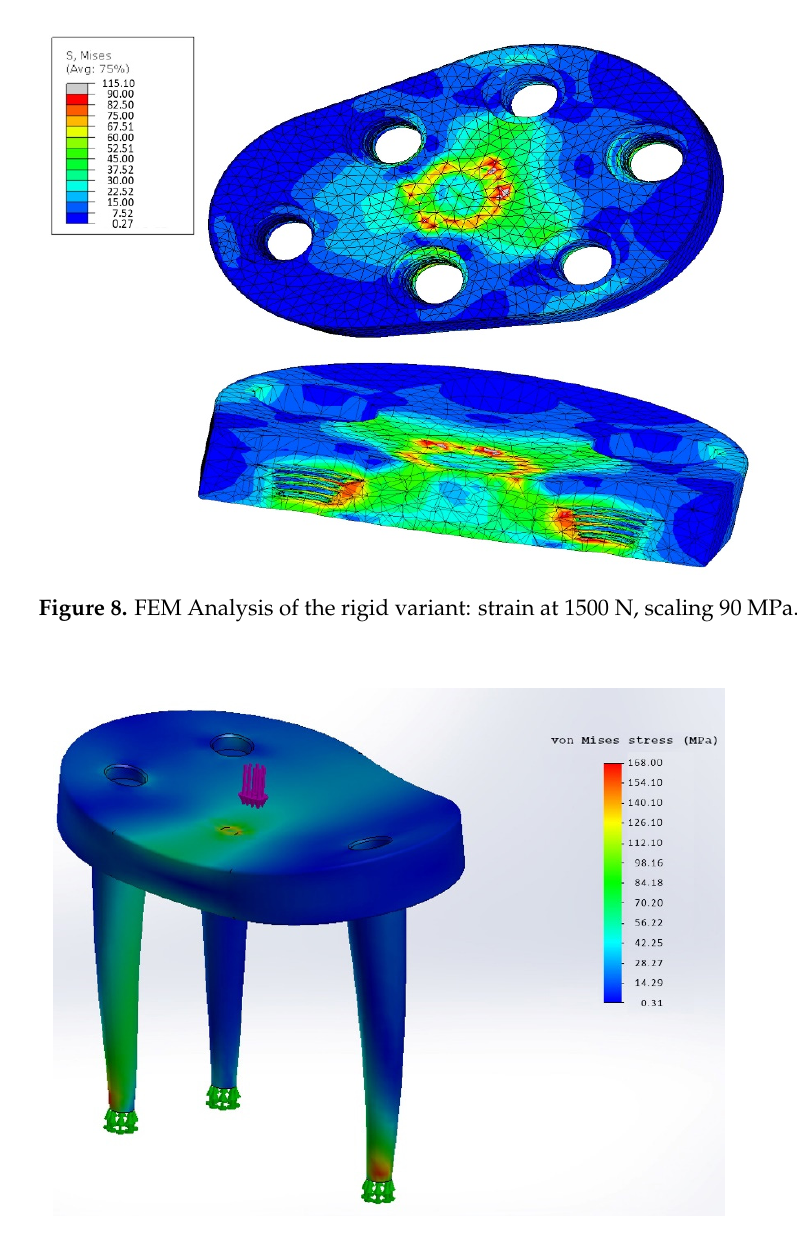
Figure 9. FEM Analysis of the Dynamic variant: strain at 500 N, scaling 168 MPa.